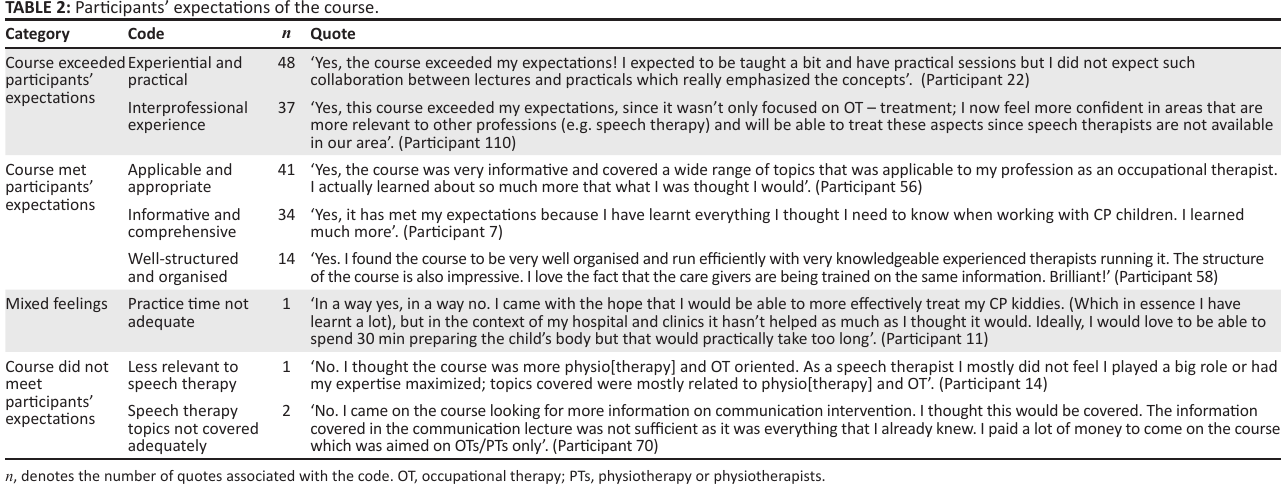
TABLE 3: Participants’ self-perceived change in level of knowledge about cerebral palsy.